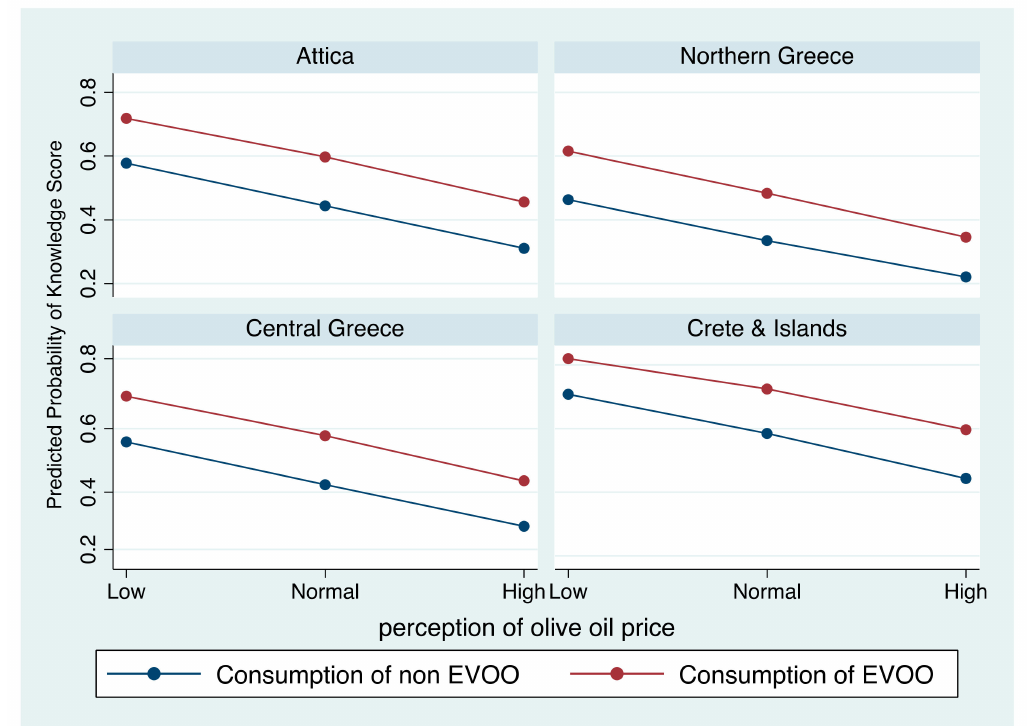
Figure 3. Adjusted Predicted Probability of extra virgin olive oil consumption according to knowledge score and price perception by